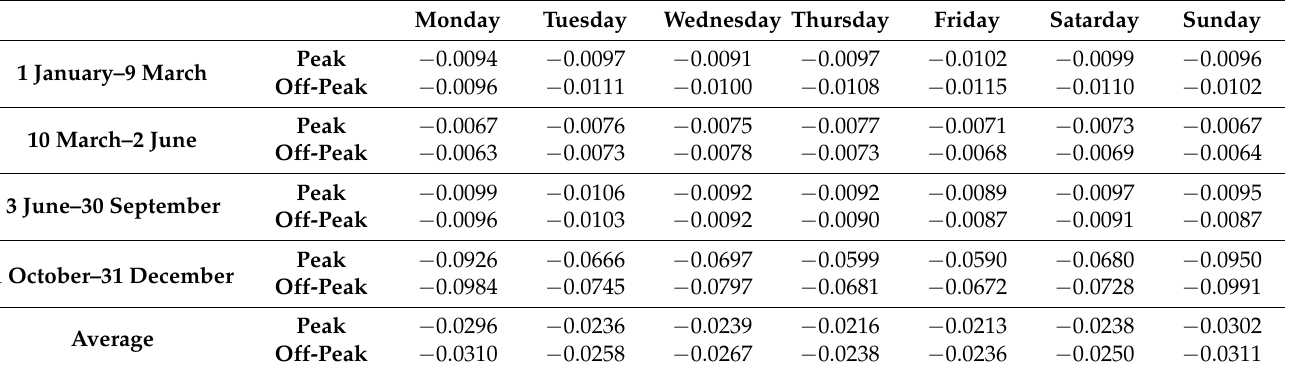
Table 9. Mean of the Hourly Elasticity Estimates, Peak and Off-peak Hours, aggregated by different periods of the year and Days of the Week.